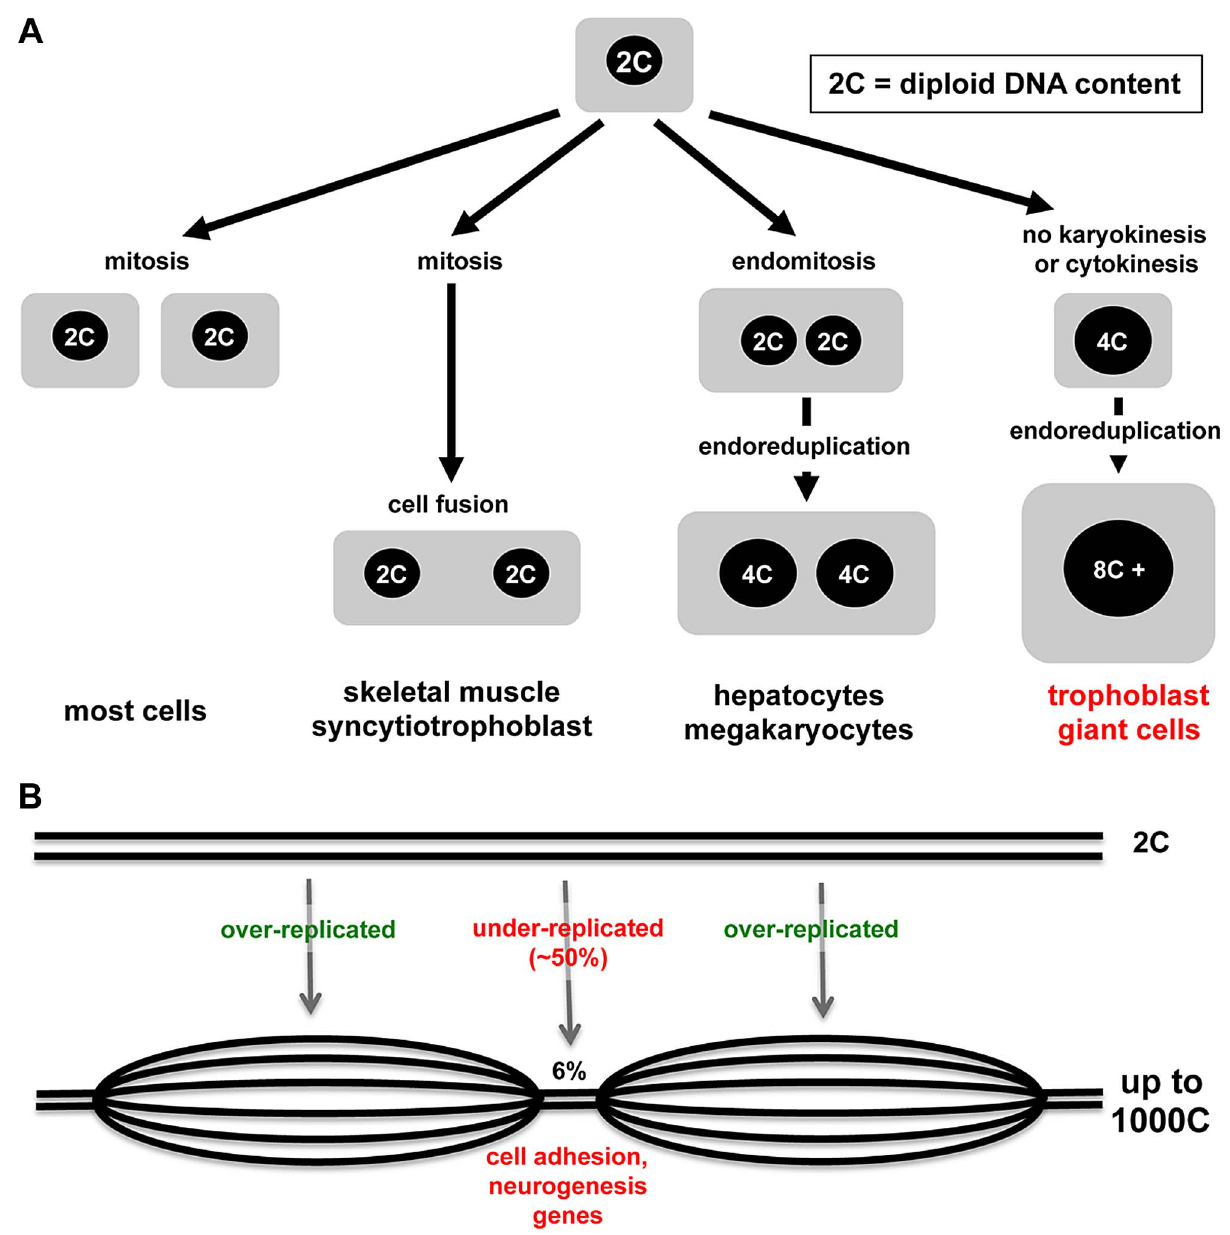
Figure 1. Modes of cell growth and polyploidy in mammals. (A) Diagram depicting different mechanisms underlying the formation of polyploid cells ranging from fusion of post-mitotic diploid cells, endomitosis (nuclear but not cell division), and endoreduplication. (B) Nuclei of polyploid trophoblast giant cells show selected small regions of under-replication (based on results from Hannibal et al.).